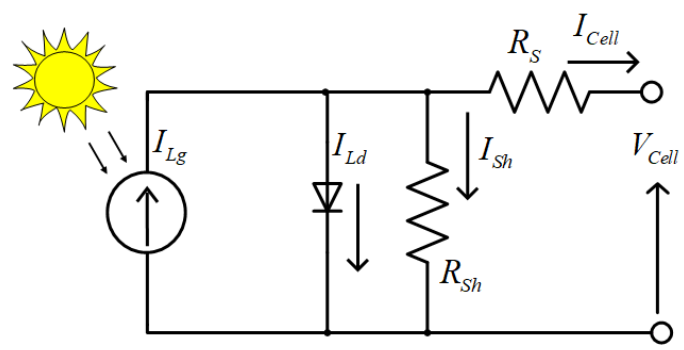
Figure 3. The equivalent of a single diode circuit of PV cell.